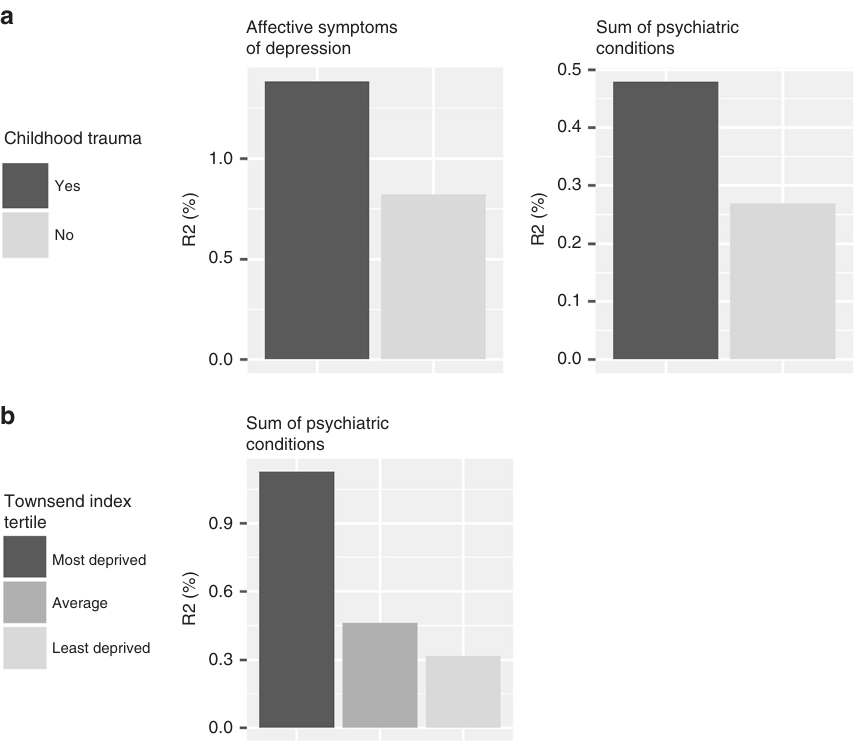
Fig. 6 G-by-E interaction. The fi gures present the variance explained by depression-PRS under the exposure of different environmental risk factors. The colour shade of each bar represents one condition of environmental factor, a darker shade represents a risk-conferring condition (i.e. had reported childhood trauma and in the most deprived area). The y axes represent the variance explained ( R 2 in %) by depression-PRS under the given environmental